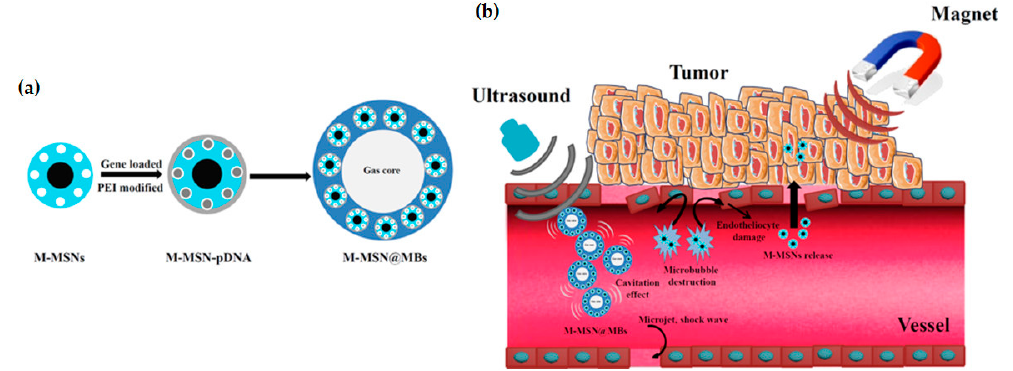
Figure 18. Schematic representation of: ( a ) construction of ultrasound responsive magnetic